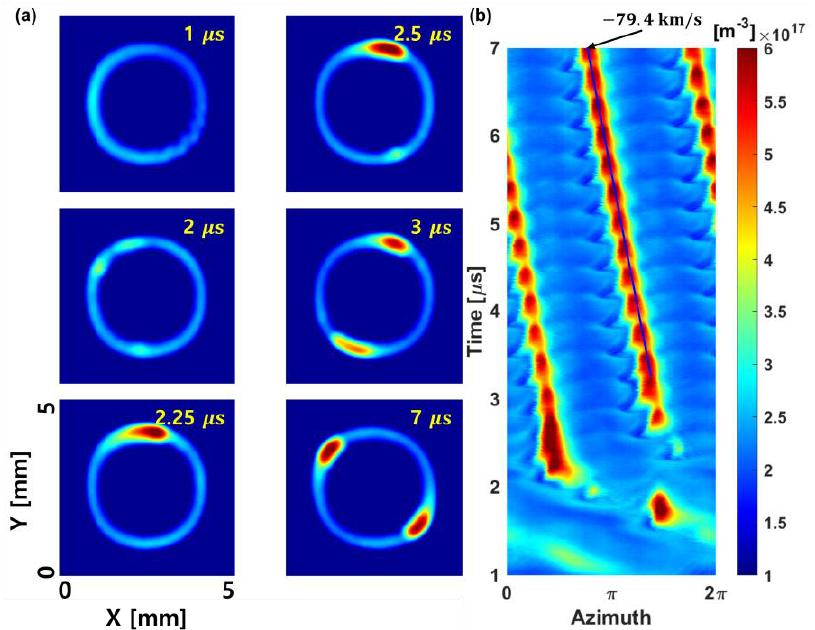
Figure 12. Time evolution of ( a ) spatial distributions of plasma density in xy plane with the symmetric magnet and ( b ) azimuthal distributions of the plasma density.